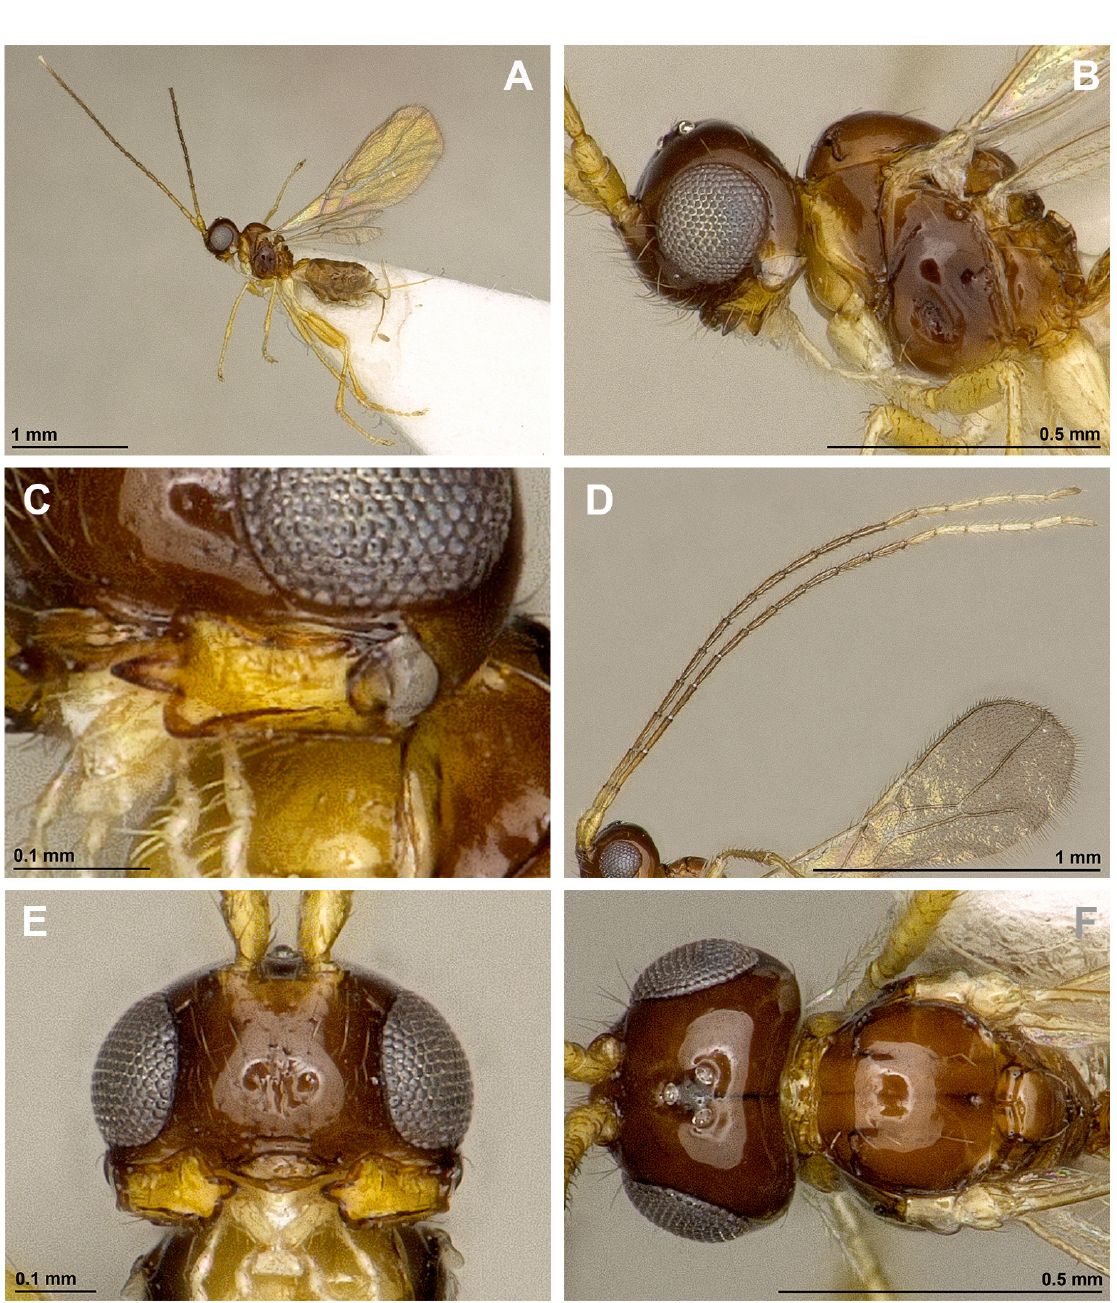
Fig. 72. Asobara vanharteni van Achterberg, sp. nov., ♀, holotype (RMNH). A . Habitus, lateral view. B . Head and mesosoma, lateral view. C . Mandible. D . Antenna. E . Head, front view. F . Head and mesoscutum, dorsal